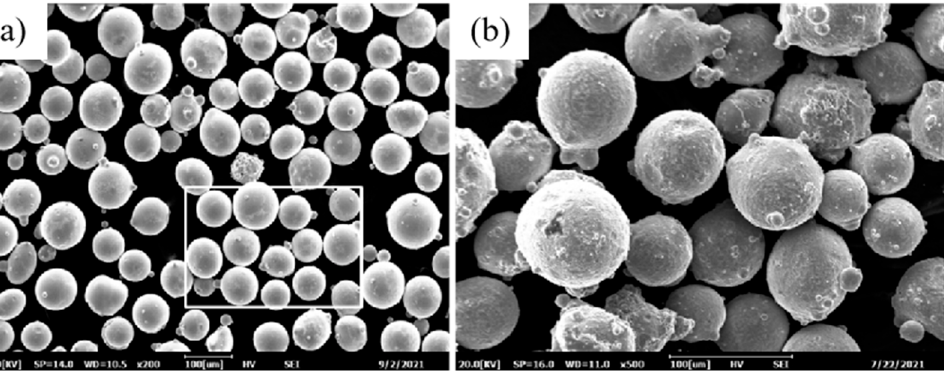
Figure 1. Electron microscope images of CoCrFeNiMn HEA powder ( a ) 200 and ( b ) 500 times.